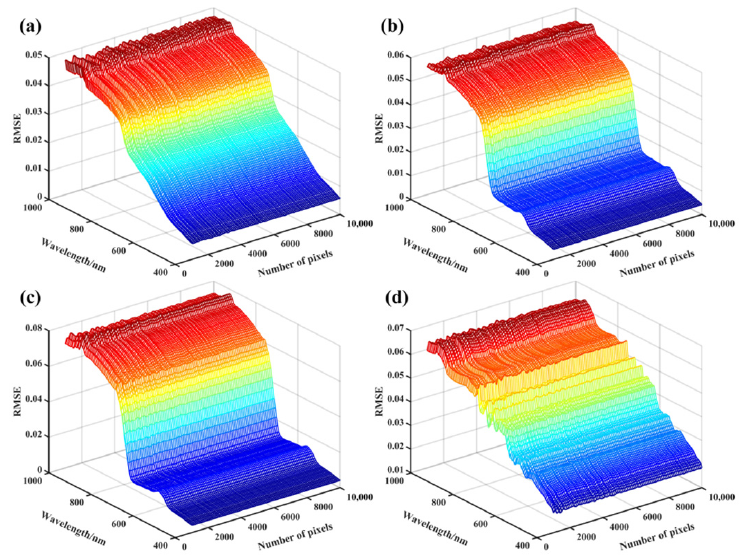
Figure 4. The RMSE of fitted reflectance with different sample numbers. ( a ) herb, ( b ) shrub, ( c ) tree, ( d ) bare